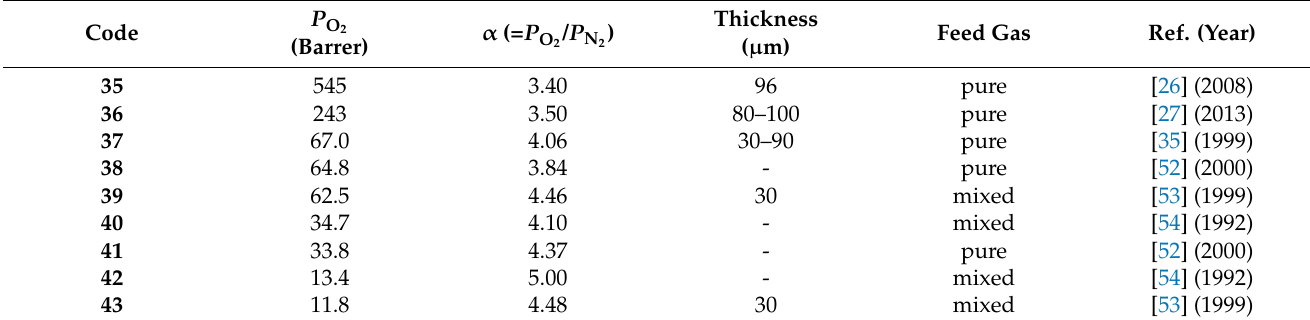
Table 3. Categorization and detail data for the membrane polymers in Figure 5 (PIs until 2013). Code